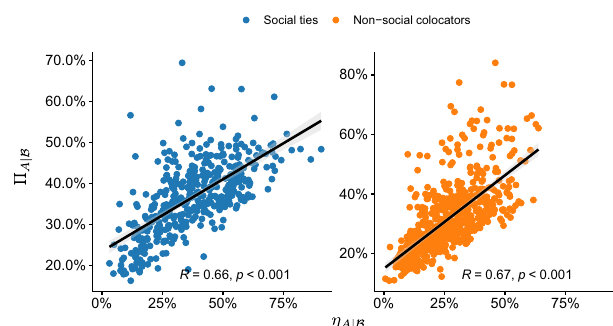
Fig. 5 Connecting location overlap to information transfer. Regression analysis of cumulative cross-predictability Π A Weeplaces dataset with the top-10 alters. Here R is Pearson ’ s correlation coef fi cient. The solid lines are linear